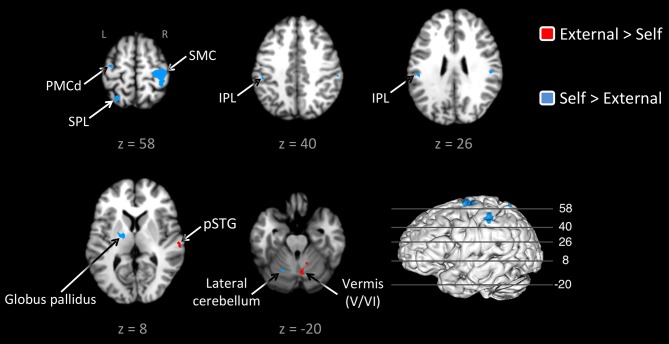
Contrast analysis between the externally-paced and self-paced ALE maps. The analyses are p < 0.05, uncorrected. The activations are color-coded according to the legend at the right. The 3D brain is shown to indicate the slice levels. The slices are shown in neurological convention. Note that the large activation in the right SMC and the corresponding activation in the left lateral cerebellum are simply a reflection of the larger number of left-handed studies for self-paced tapping (see text). Abbreviations: IPL, inferior parietal lobule; L, left; PMCd, dorsal part of the premotor cortex; R, right; SMC, sensorimotor cortex; SPL, superior parietal lobule.